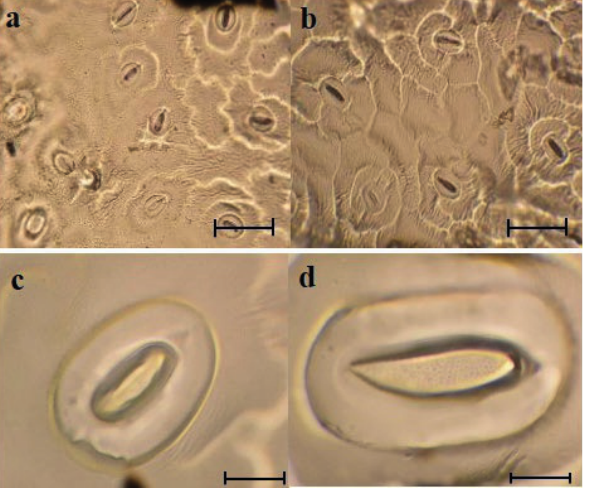
Figure 7. Abaxial stomata in leaves of S. mutica ; stomatal density in tetraploid (a) and octaploid plant (b) (Bars = 50 µm); stomatal size in tetraploid (c) and octaploid plant (d) (Bars = 5 µm).